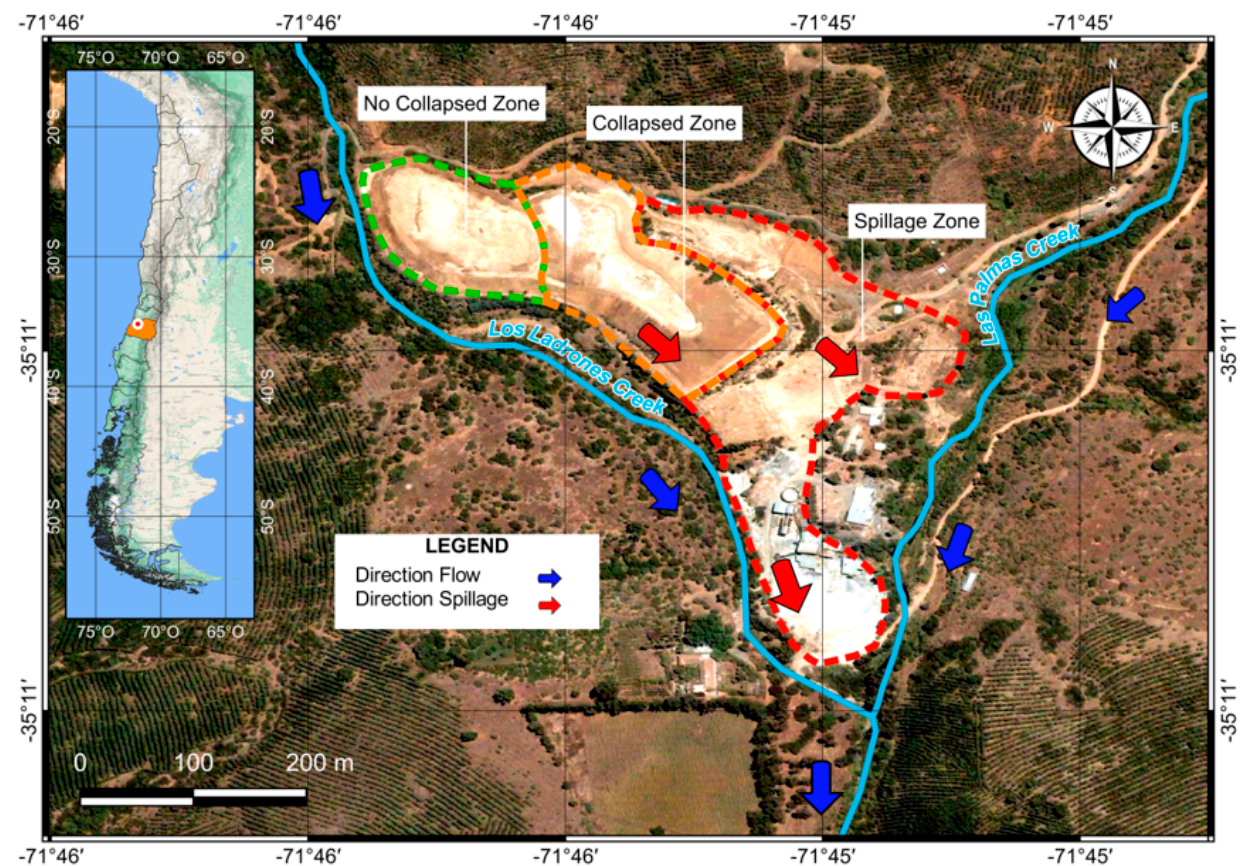
Figure 15. Area affected by mining tailings spill in Las Palmas Creek (Modified from [63]).